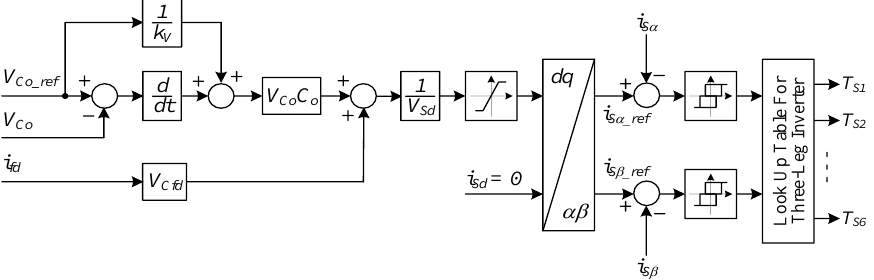
Figure 4. Diagram of the current control scheme for the three-leg inverter.